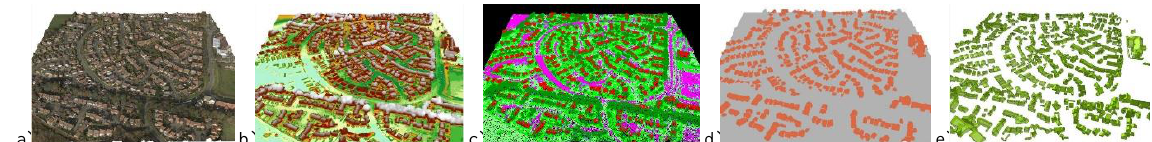
Figure 5: Different products realized from an oblique flight: dense and coloured point cloud (a), colour-coded DSM (b), classified dense point cloud (c), extracted points representing buildings (d) and reconstructed building block models in LOD2